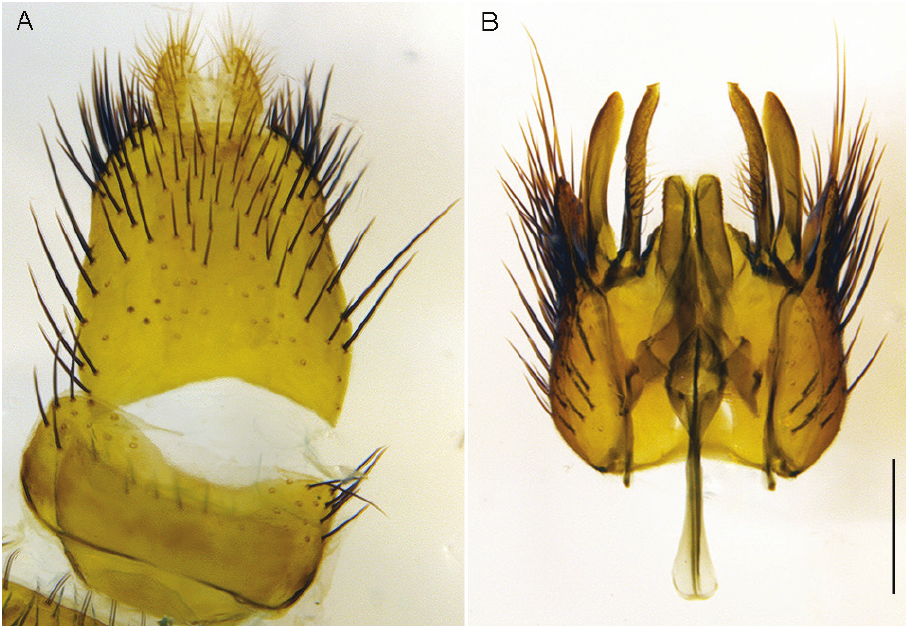
Figure 16. Sidarena macfarlandi sp. n., male genitalia: A Epandrium and tergite 8, dorsal view B Gono- coxites and aedeagus, dorsal view (epandrium removed). Scale line: 0.2 mm.